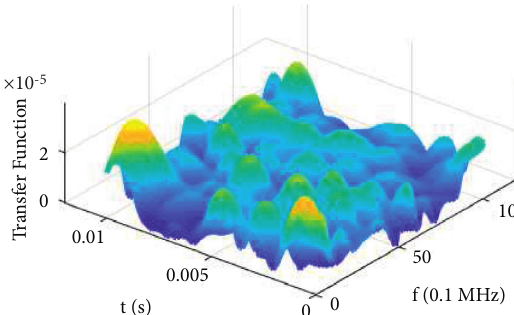
Figure 5: The time-frequency channel transfer function of the scattering path.